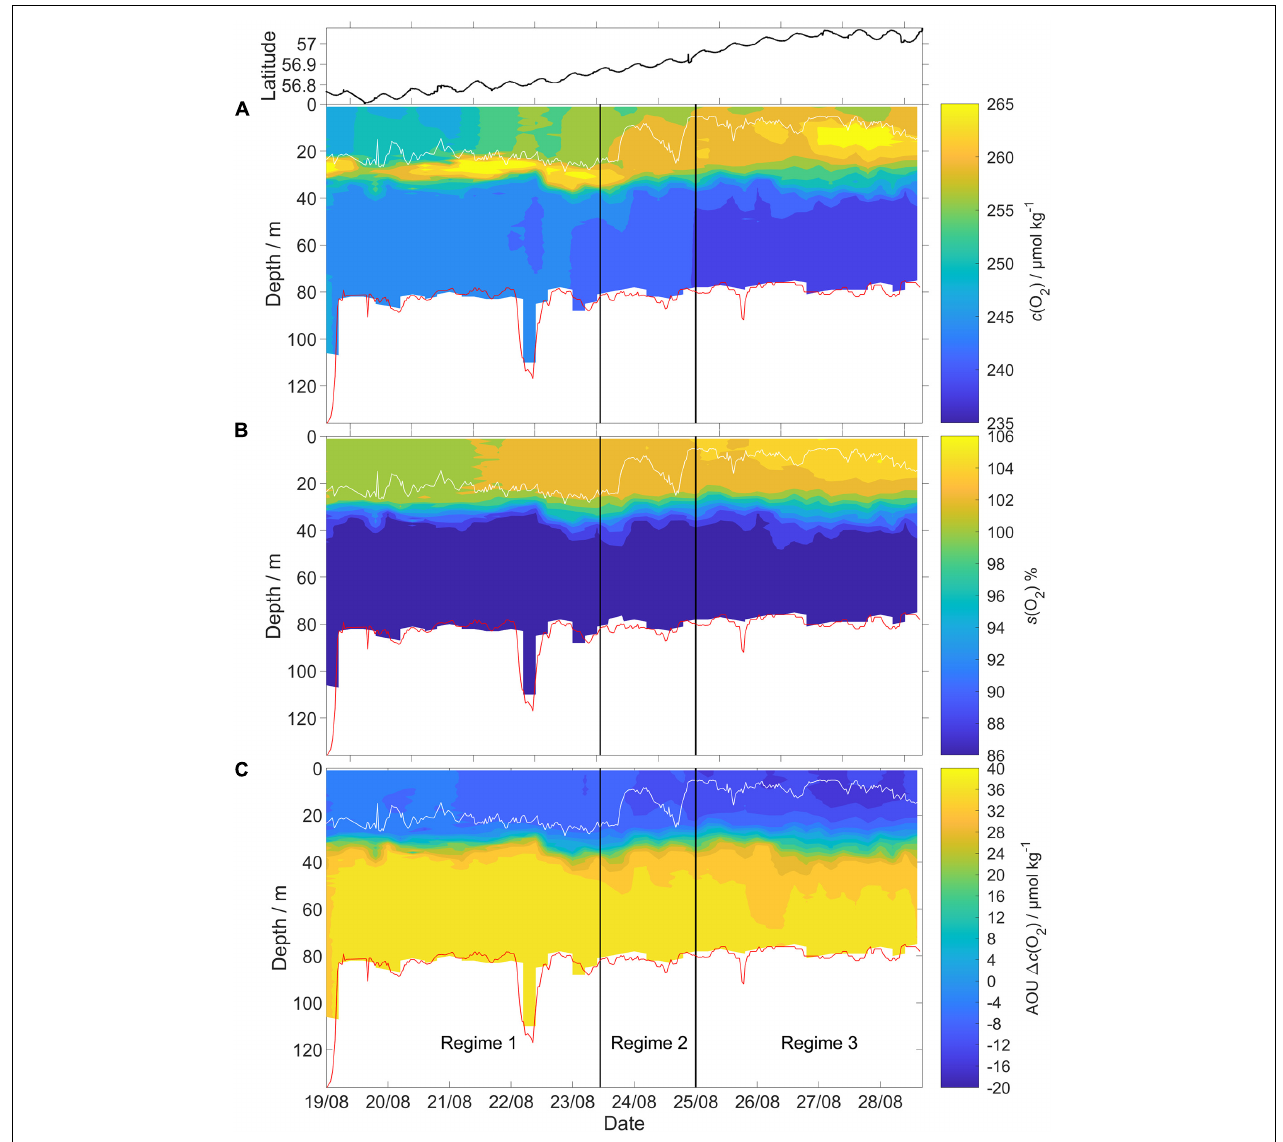
FIGURE 6 | The glider deployment was divided into three different regimes based on salinity. Each regime also had a distinct vertical pattern of (A) c (O 2 ), (B) the saturation ratio [ s (O 2 )] percentage, defined as c (O 2 )/ c sat (O 2 ) × 100, and (C) apparent oxygen utilization (AOU) calculated according to the method in section “Apparent Oxygen Utilization (AOU).” The vertical black lines show the regime boundaries. White line: surface mixed layer depth ( z mix ). Red line: GEBCO bathymetry. Top panel: glider